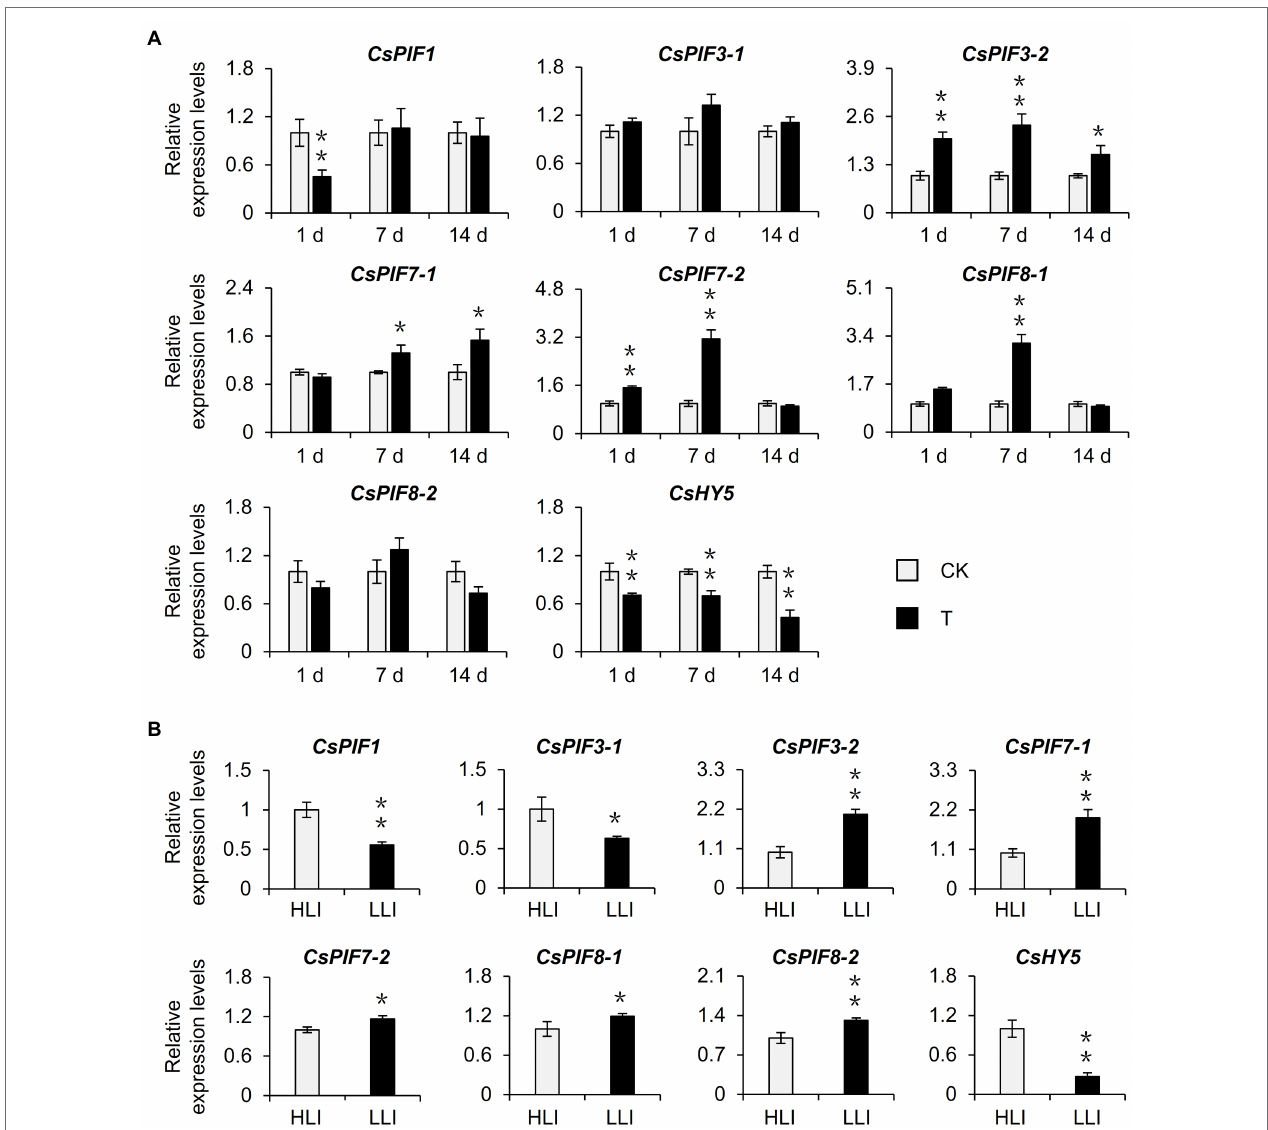
FIGURE 4 | Effects of shading and reduced light intensity on the expression of genes related to the light signal pathway in tea plants. (A) Changes in the expression of genes related to light signal in tea plants under shading treatment. CK: no shading treatment group (about 1,300 μ mol m − 2 s − 1 ); T: 90% shading treatment group (about 130 μ mol m − 2 s − 1 ). (B) Changes in the expression of light signal-related genes in tea plants under reduced light intensity. HLI: high-light intensity treatment group (252 μ mol m − 2 s − 1 ); LLI: low-light intensity treatment group (16.8 μ mol m − 2 s − 1 ), and R: FR for two groups were 1.5. CsEF1- α was used as an internal reference to normalized the changes. Data are expressed as mean ± SD ( n = 3). * p ≤ 0.05; ** p ≤ 0.01; and difference from CK treatment at the same time